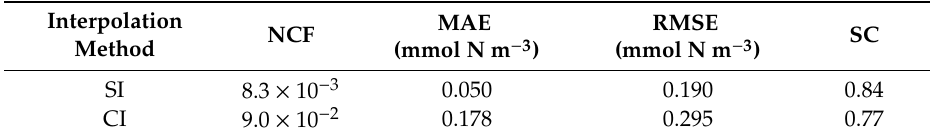
Figure 4 . Distributions of P inverted with the adjoint method combined with the spline interpolation (SI) ( A ) and the Cressman interpolation (CI) ( B ) in IE1 (unit: mmol N m − 3 ).